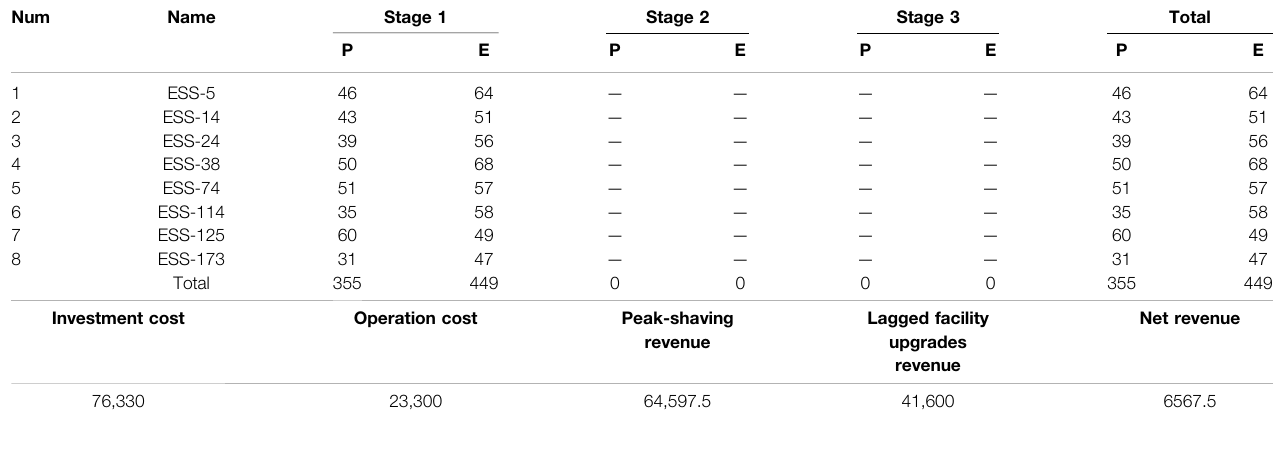
TABLE 2 | Energy storage system planning results of each stage of case II.